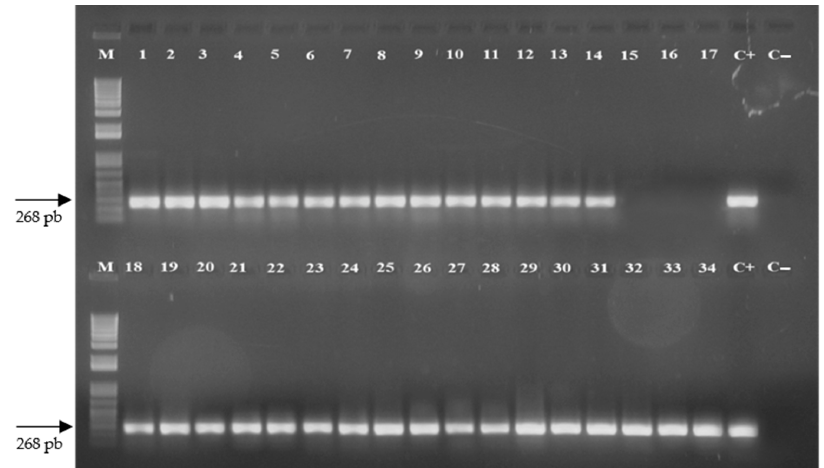
Figure 2. PCR amplification based on cDNA of Pera sweet orange plants to determine the expression of the stx IA gene. Lanes: M, molecular marker; 1–7, plants of the STX-5 transgenic line; 8–14, plants of the STX-11 transgenic line; 15–17, non-transgenic control plants (control); 18–26, plants of the STX-12 transgenic line; 27–34, plants of the STX-13 transgenic line; C+, positive control using the pST10 plasmid containing the stx IA gene; and C − , negative control.